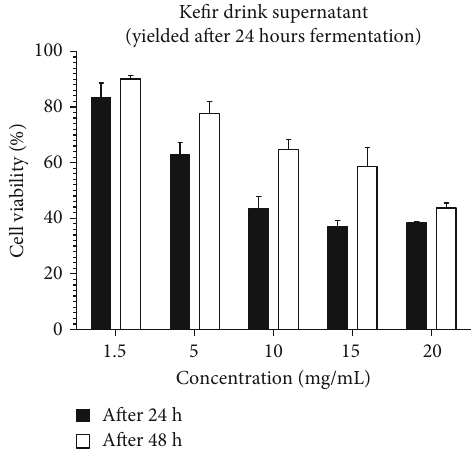
Figure 2: E ff ect of ke fi r drink supernatant (yielded after 24 hours fermentation) on U87 cell viability after 24 and 48 hours ( P value ≤